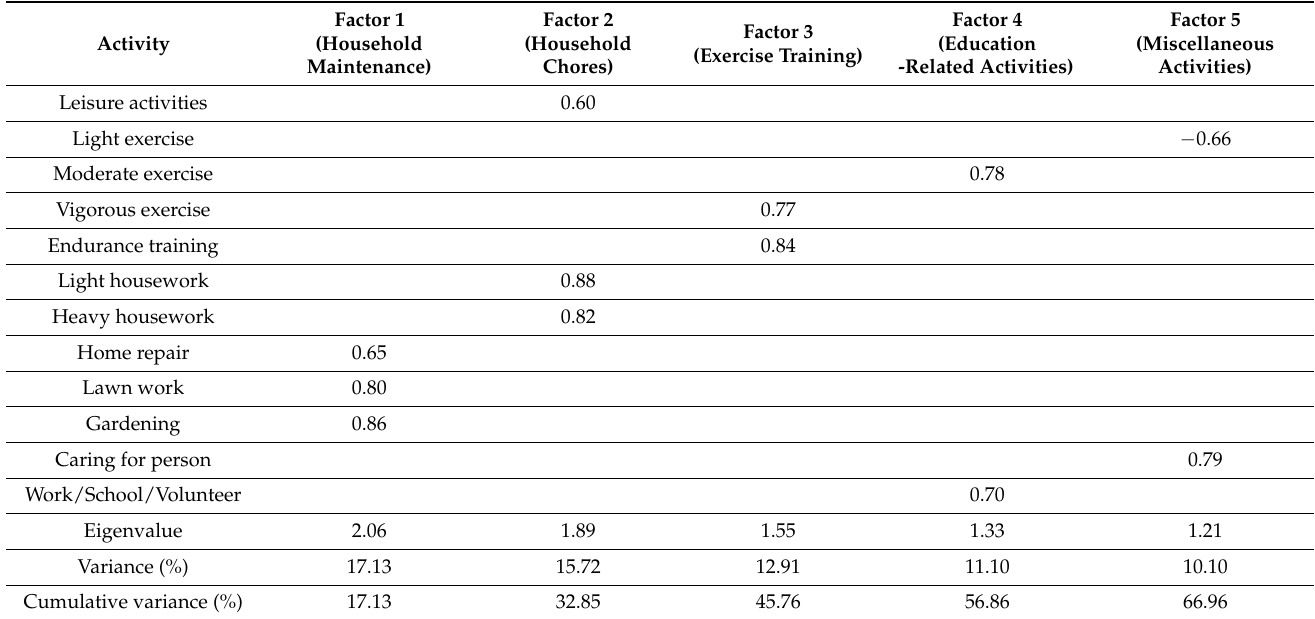
Table 3. Factor analysis of the Physical Activity Scale for Children (combined).